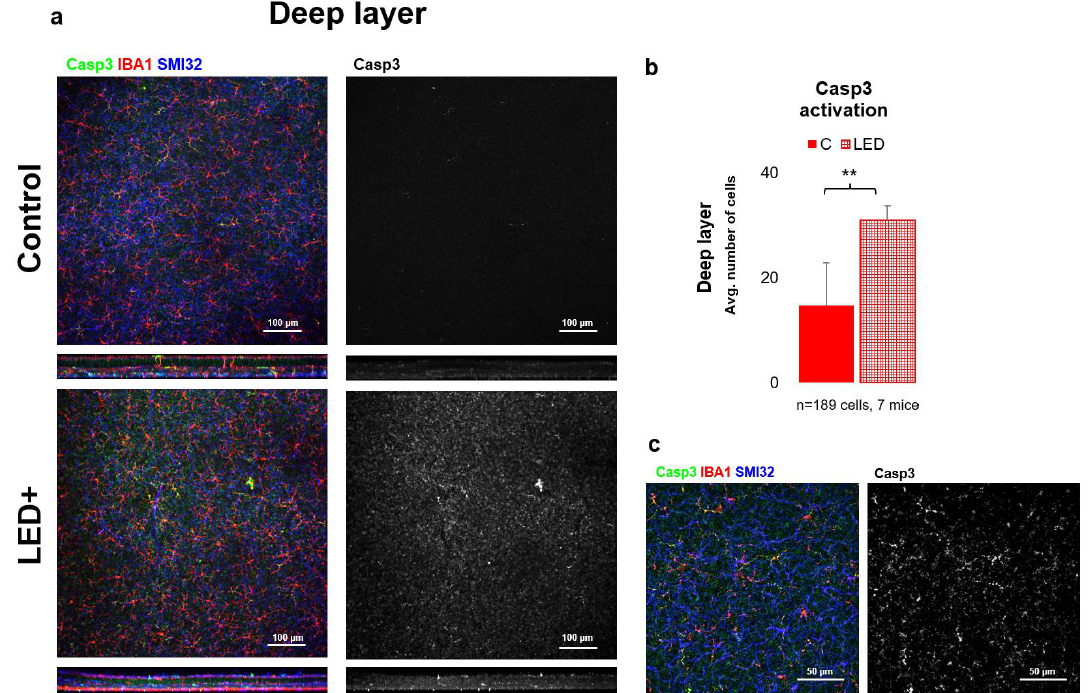
Figure 5. Casp3 activation in the deeper parts of the retina. Panel ( a ) of the figure shows the outer core layer of control and LED retinas labeled SMI32 (GC marker), Iba1 (MG marker), and Casp3 (Casp3+ cells) scanned with a 20x objective in a confocal microscope. The colors shown are the same as the colors above the images. In the second column, only Casp3-activated cells are shown in white. In panel ( b ) the histogram shows the number of activated cells counted in the DL (** p = 0.01). Panel ( c ) shows high-magnification confocal microscopic images scanned with a 63x objective. The triple-labeled and only Casp3-acti- vated cells are visible from the LED retinas.